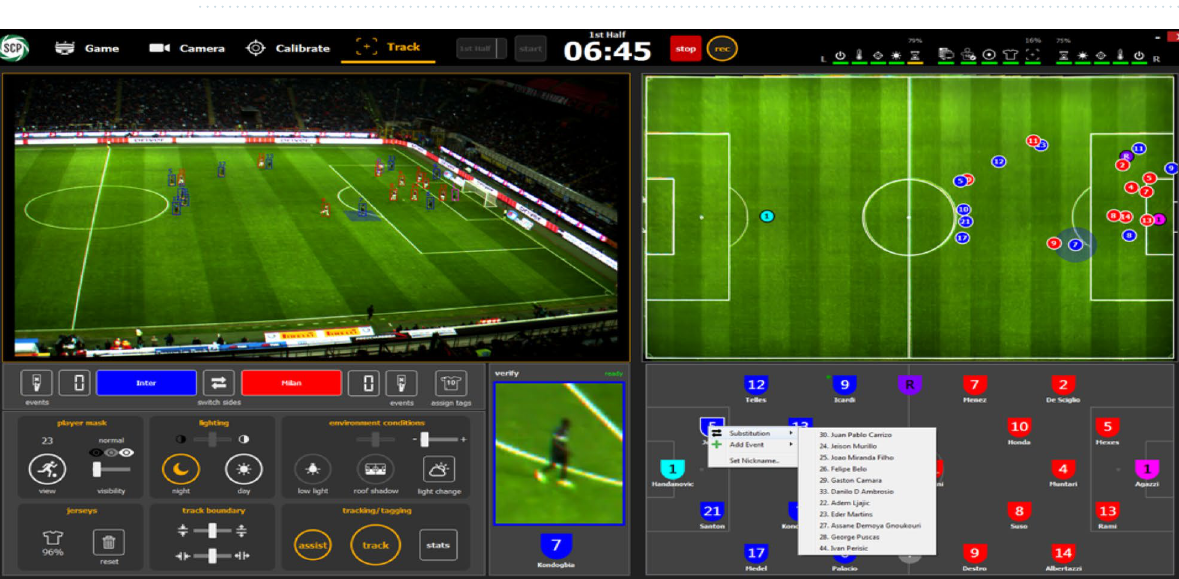
Figure 3. Sentio Sports optical tracking system field calibration.